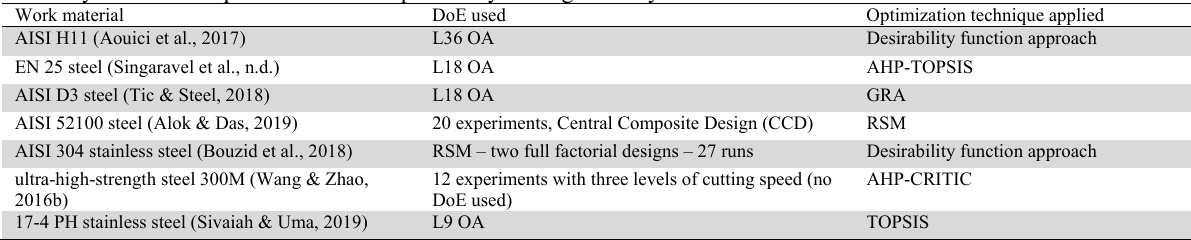
Summary of different optimization techniques in dry turning for alloy steels Work material DoE used Optimization technique applied AISI H11 (Aouici et al., 2017) L36 OA Desirability function approach EN 25 steel (Singaravel et al.,